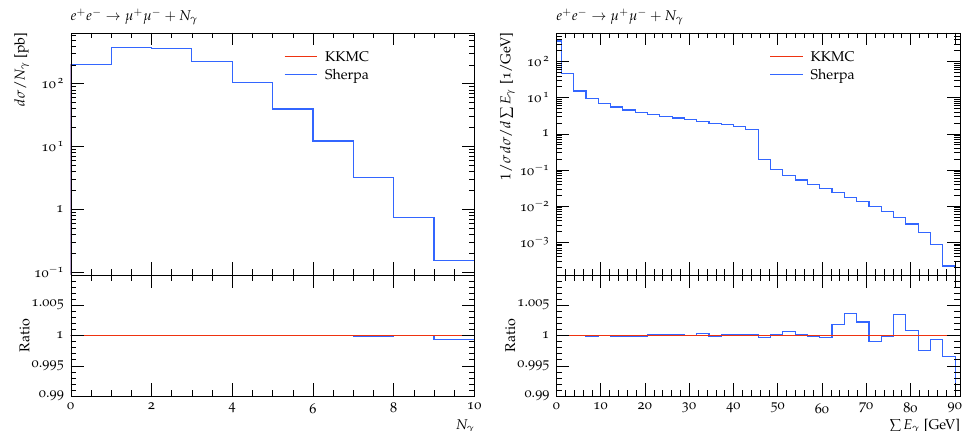
Figure 3: The total number of photons for both ISR and FSR (left), and the total sumeed photon energy (right), comparing S HERPA with K KMC